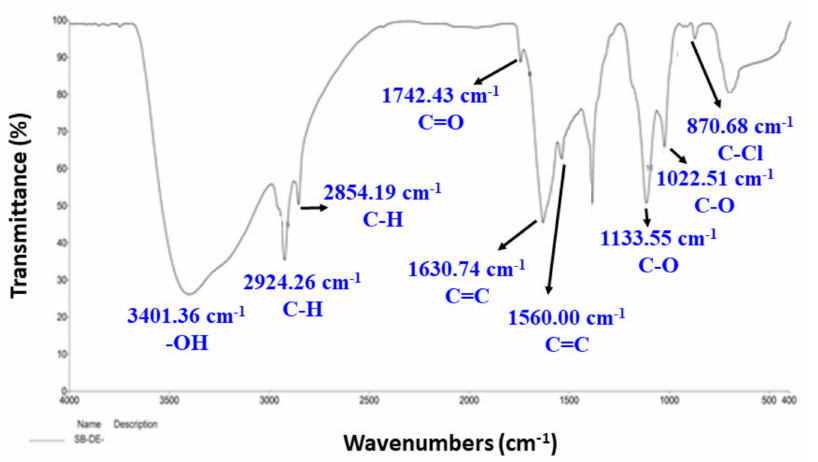
Figure 2. FT-IR spectrum of aqueous leaf extract of SA.